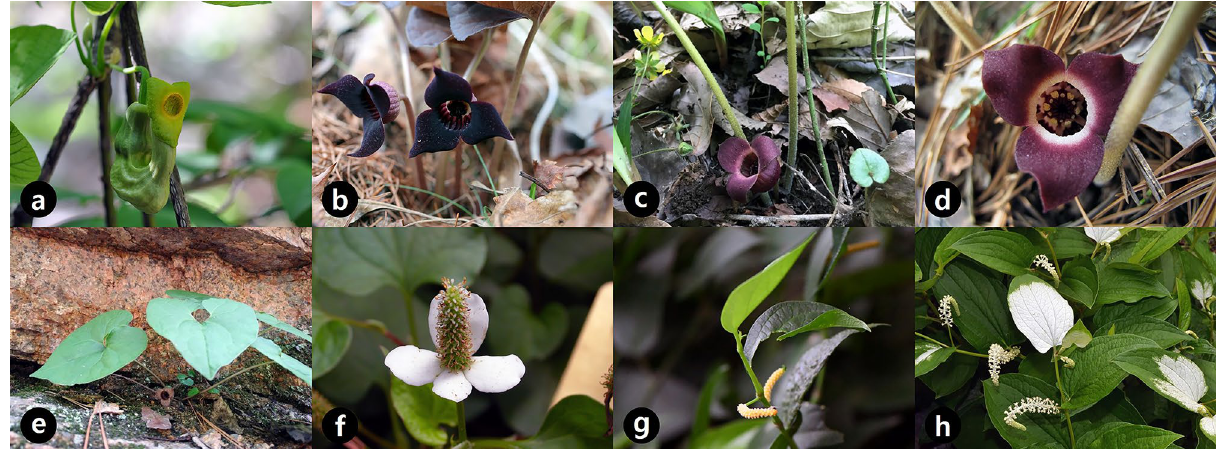
Figure 1. Flowers and inflorescence of representative genera of the Korean Piperales ( a ) Aristolochia manshuriensis . ( b ) Asarum koreanum . ( c ) Asarum mandshuricum var. seoulense . ( d ) Asarum sieboldii . ( e ) Asarum versicolor . ( f ) Houttuynia cordata . ( g ) Piper kadsura . ( h ) Saururus chinensis . ( a – d , f , h ) were obtained by Jun-Ho Song, and ( e , g ) were obtained by Sungyu